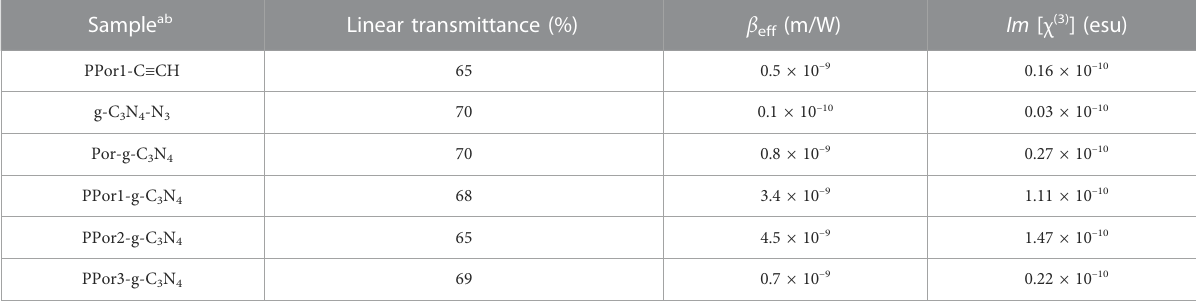
TABLE 1 NLO properties of as prepared samples in